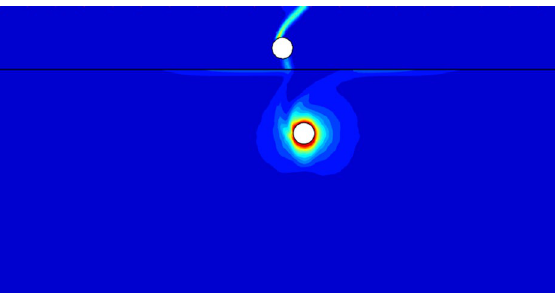
Figure 13. The UB failure mechanism of c u1 / c u2 = 3, X / D = 1, Y / D =